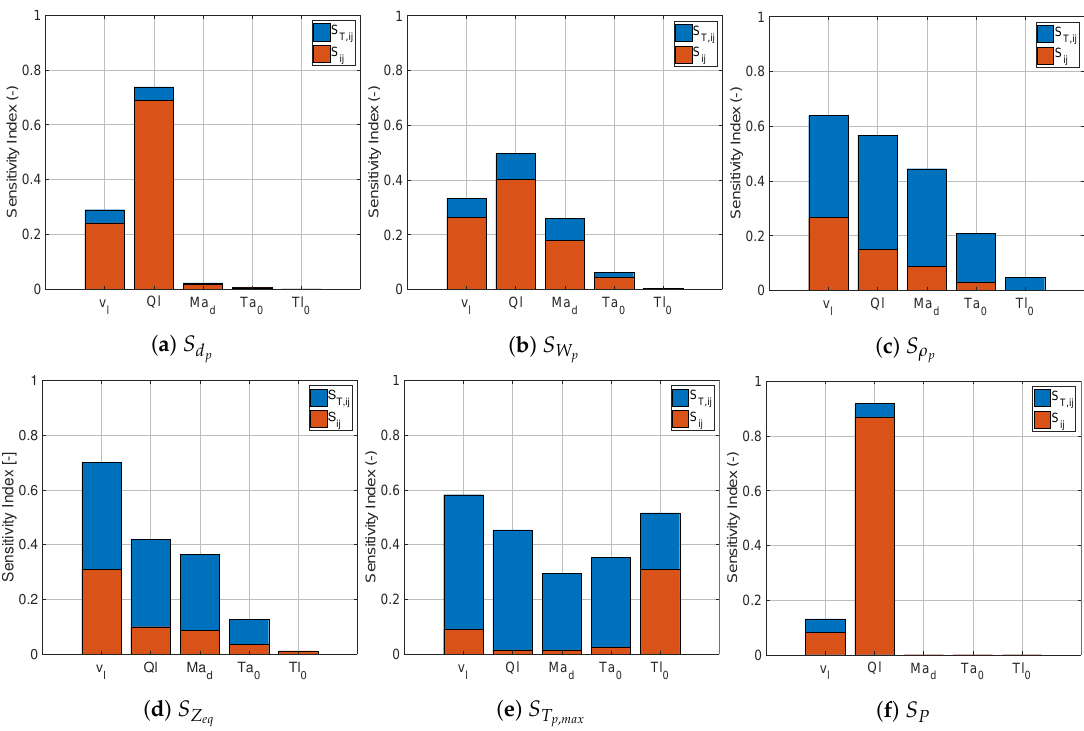
Figure 9. Sensitivity indices ( S i , S T , i ∀ i ∈ { d p , W p ρ p Z eq T p , max P } ) for the spray dryer operating with a pressure nozzle calculated using fourth order PCE with 600 samples.